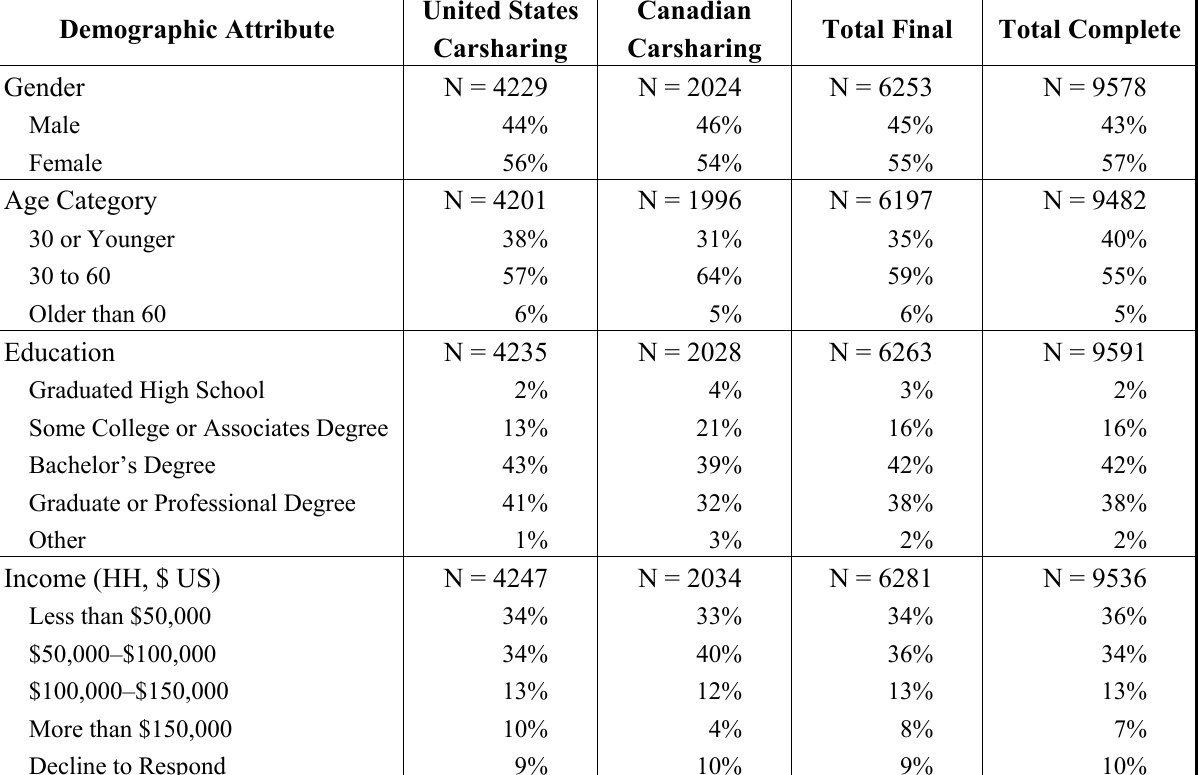
Table 1. Demographics of the North American Carsharing Member Sample. Demographic